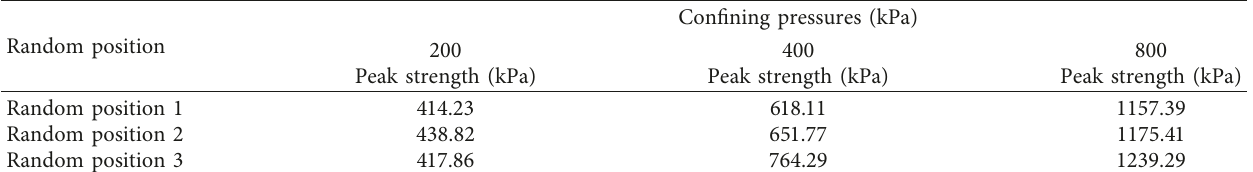
Table 5: Peak strengths at different random positions under different confining